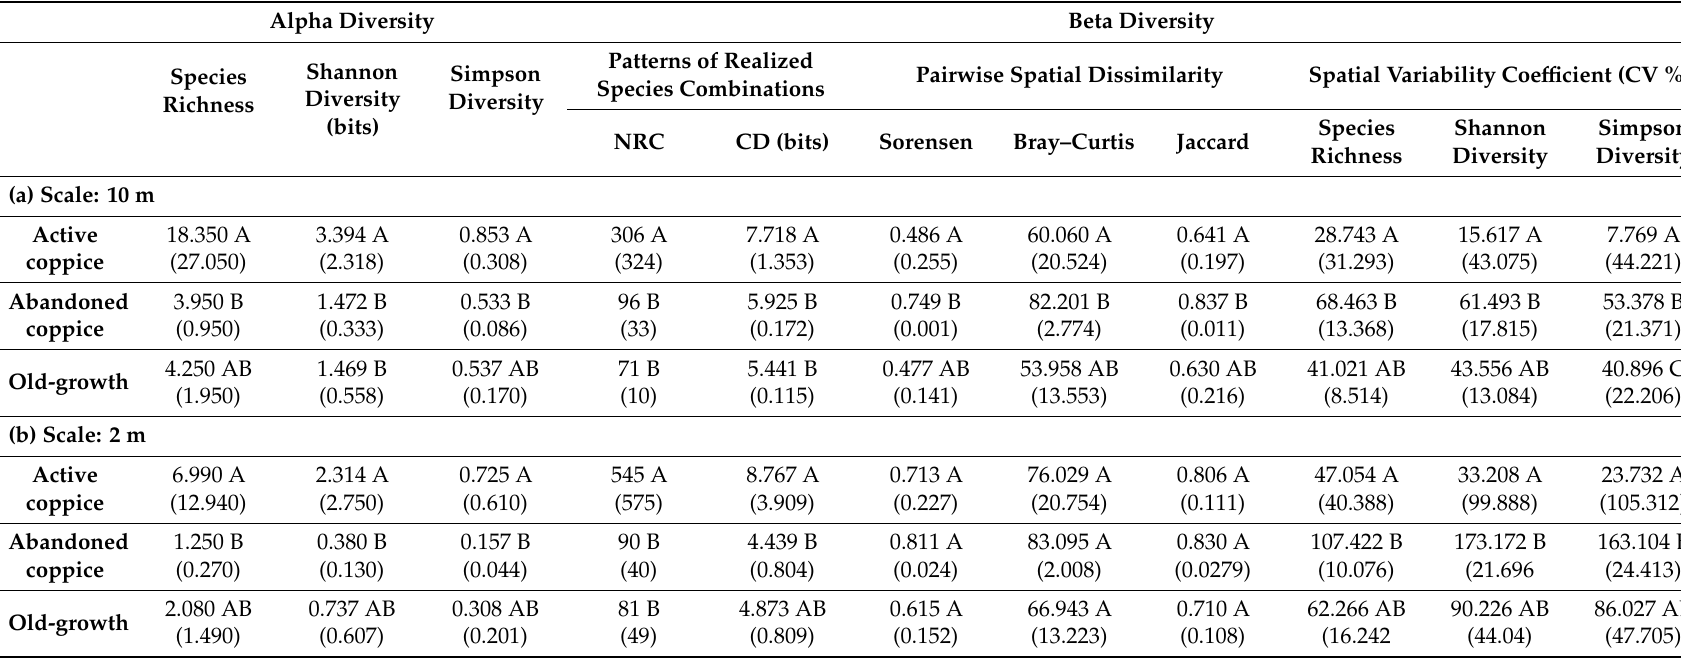
Table 2. Medians and ranges (in parentheses) of estimated diversity characteristics in the successional stages (all species considered). Significant di ff erences between stages were evaluated by the Kruskall–Wallis non-parametric rank test and indicated by letters ( p < 0.05 Bonferroni adjusted post-hoc